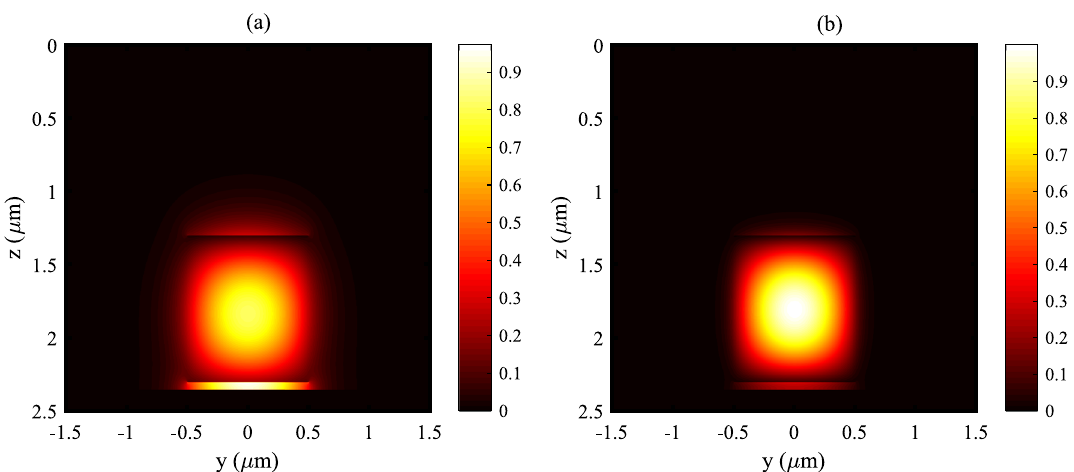
Figure 5. The absolute value of electric field along the ˆ z direction for the TM plasmonic based hybrid mode at = 1550 nm ( a ) and the TM true guided mode at (cid:31) (cid:31) p